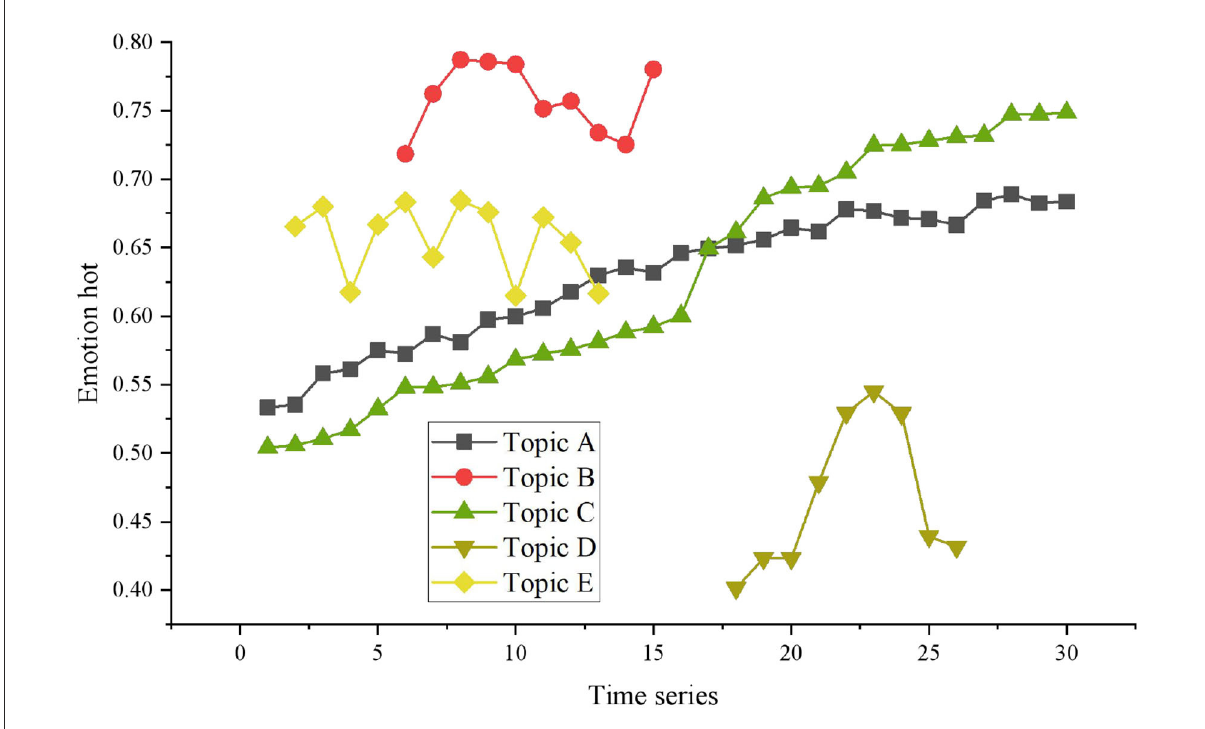
FIGURE7 Analysis of the evolution trend of